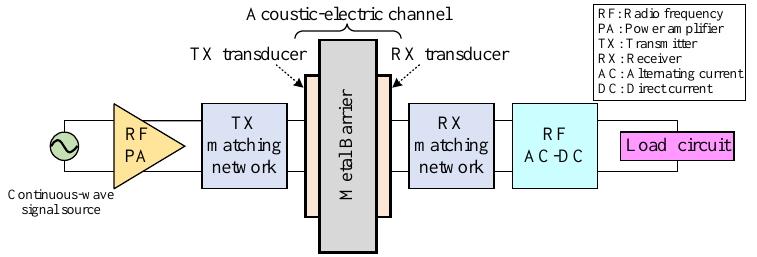
Figure 1. Block diagram of the ultrasonic through-metal-wall power transfer